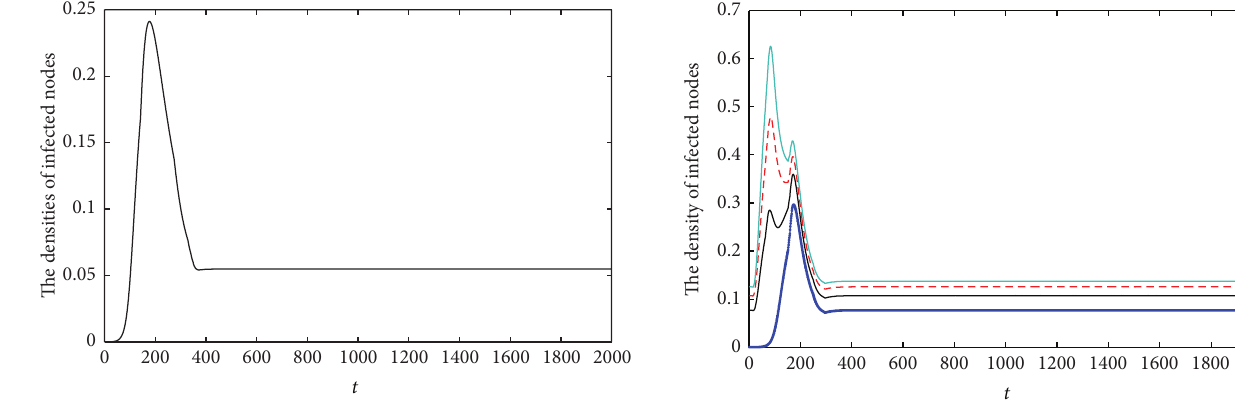
Figure 3: The density of infected nodes with parameters 𝜇 = 0.01 , = 0.01 , 𝑟 = 0.06 , 𝑟 = 0.06 , 𝛼 = 0.005 > 𝛼 𝑟 𝑠 1 2 𝑁 = 100000 .